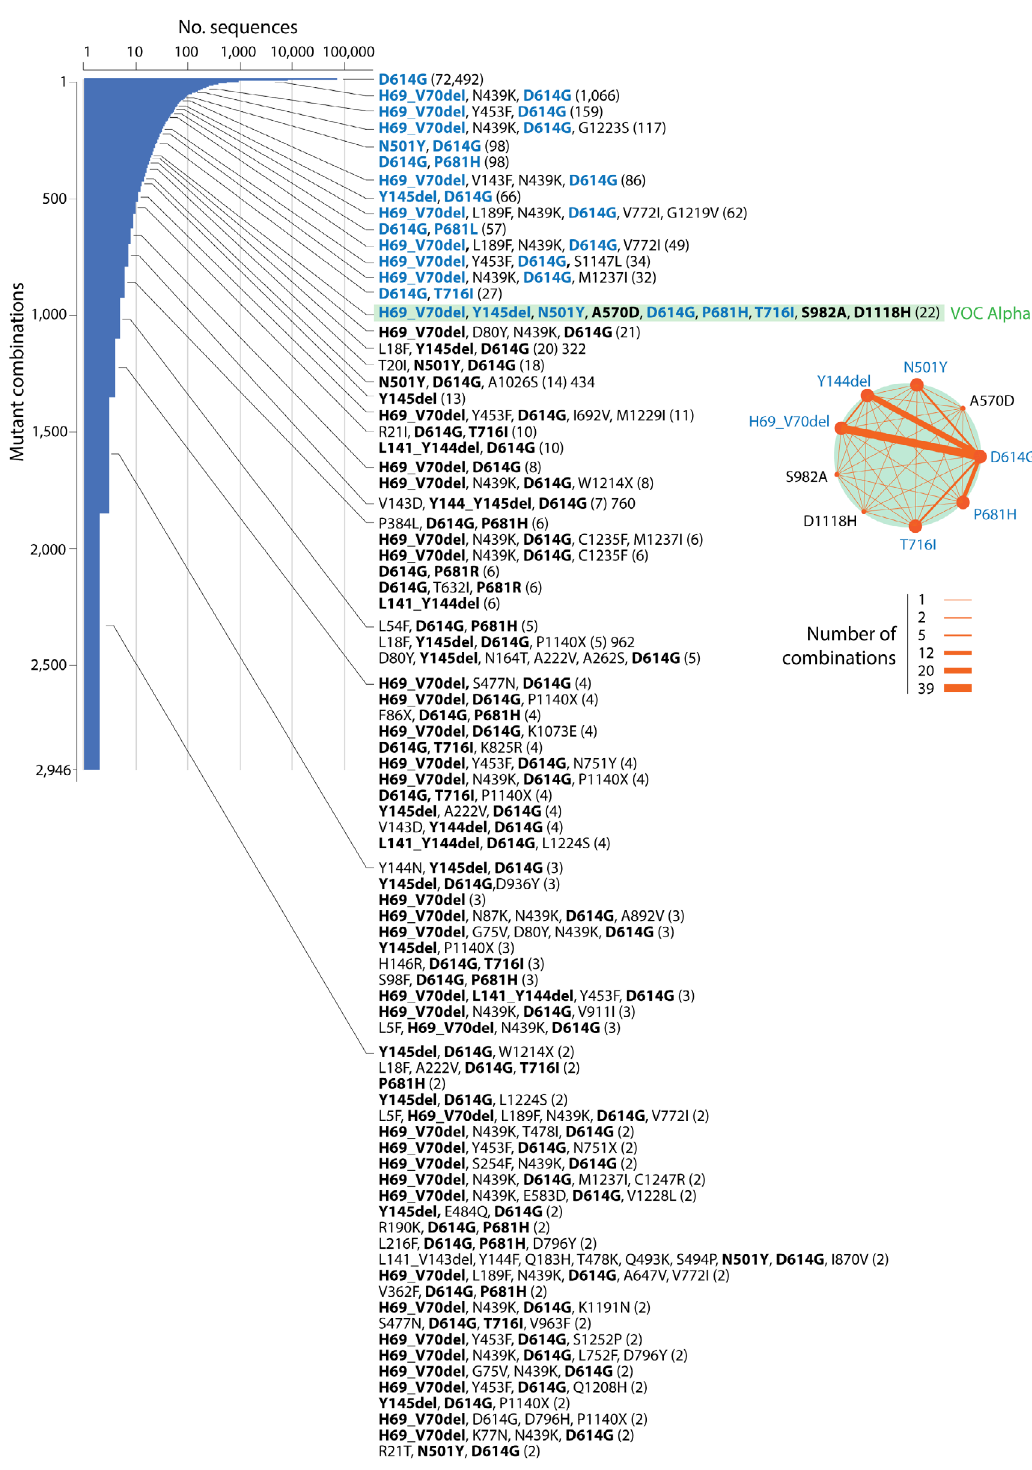
Figure 4. A frequency distribution plot describing the prevalence of S-protein mutant combinations appear- ing prior to VOC emergence during the first year of the COVID-19 pandemic. The plot is indexed with the names of 83 combinations harboring markers of the VOC Alpha constellation (in bold) and corresponding prevalence (numberofsequencesinparentheses).NotethatVOCAlphawasreportedamonthafterthesamplingofthe137,605 S-proteinsequencesanalyzedonNovember14,2020.Markershighlightedinbluehaveahigherprevalencethanthe 22 sequences of a single mutant combination harboring all markers of VOC Alpha (highlighted in green). They represent 67% of markers of that combination, offering ample opportunities for recombination. The inset shows a network of co-occurrence of markers of the VOC Alpha constellation. Nodes are mutations and links of the graph represent their co-occurrence. Data were retrieved from the Supplementary Tables in Showers et al. (2022).